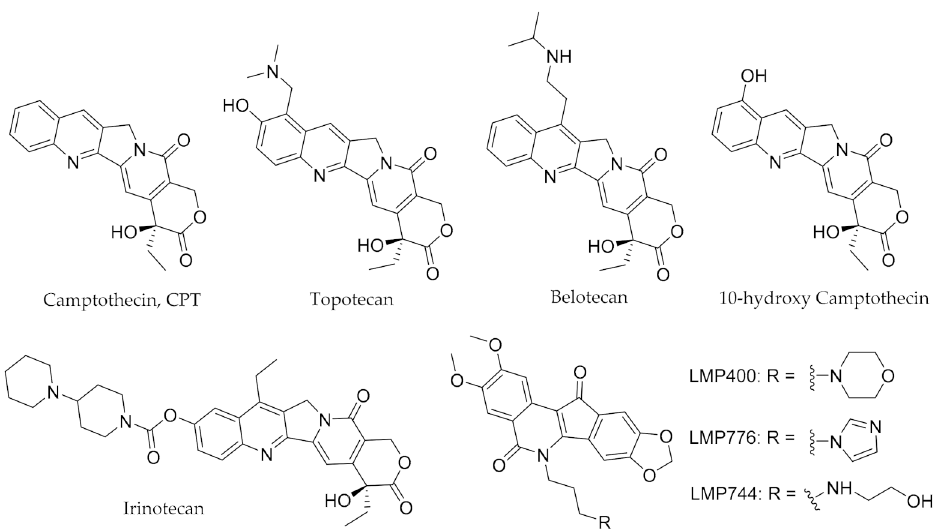
Figure 1. Chemical structures of representative camptothecins derivatives and non-camptothecin Top1